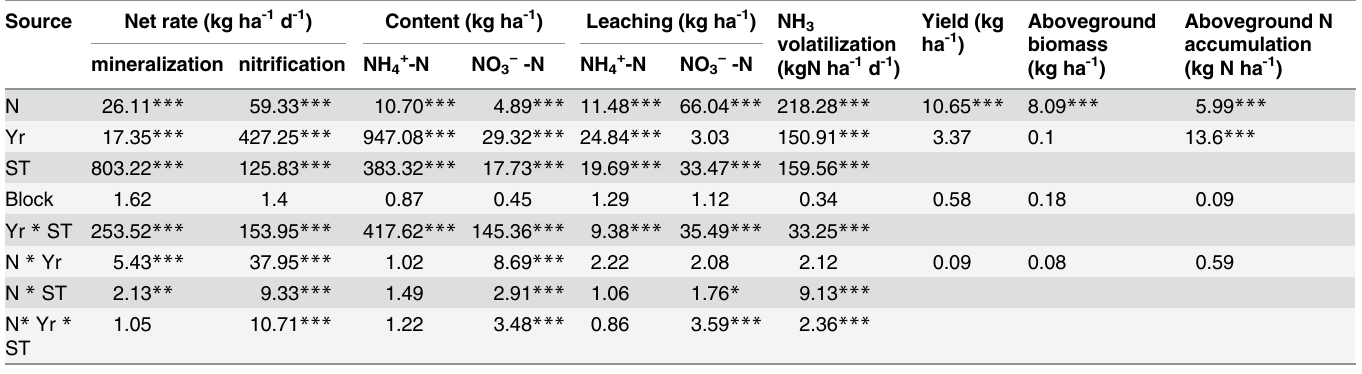
Table 1. Results ( F and P values) of the GLM ANOVA for the effects of N, years and sampling times on soil net N mineralization rate and nitri fi cation rate, inorganic N content, inorganic N leaching, NH 3 volatilization rate, corn yield, aboveground biomass and aboveground N